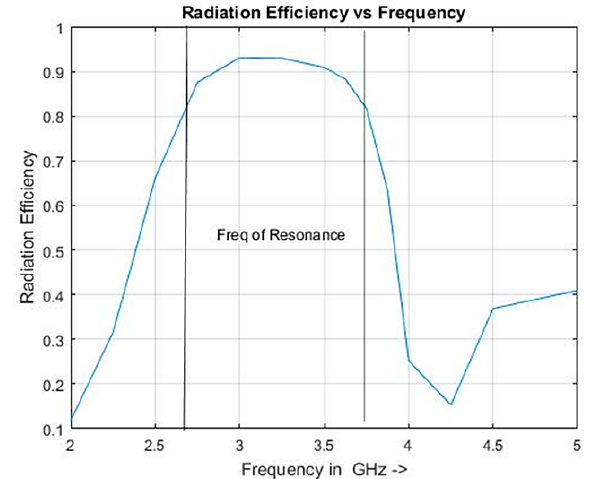
frequency range of 2.7 GHz to 3.8 GHz. Also, the Gain (dBi) vs Frequency (2 GHz – 5 GHz) plot is shown is Fig. 10. It is